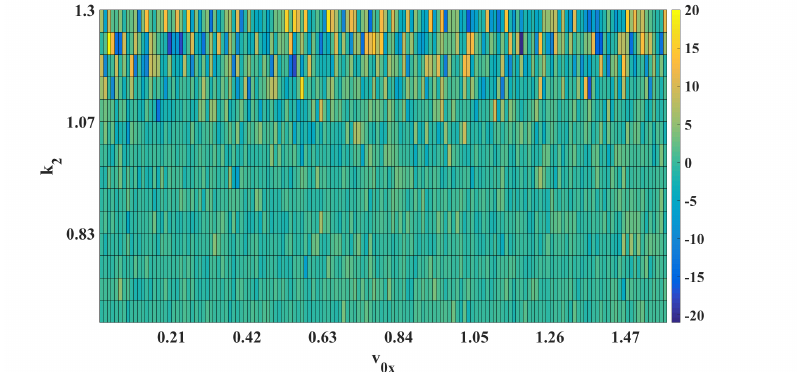
Figure 13. Basin of attraction of settling locations for v 0 x with changes in k 2 .